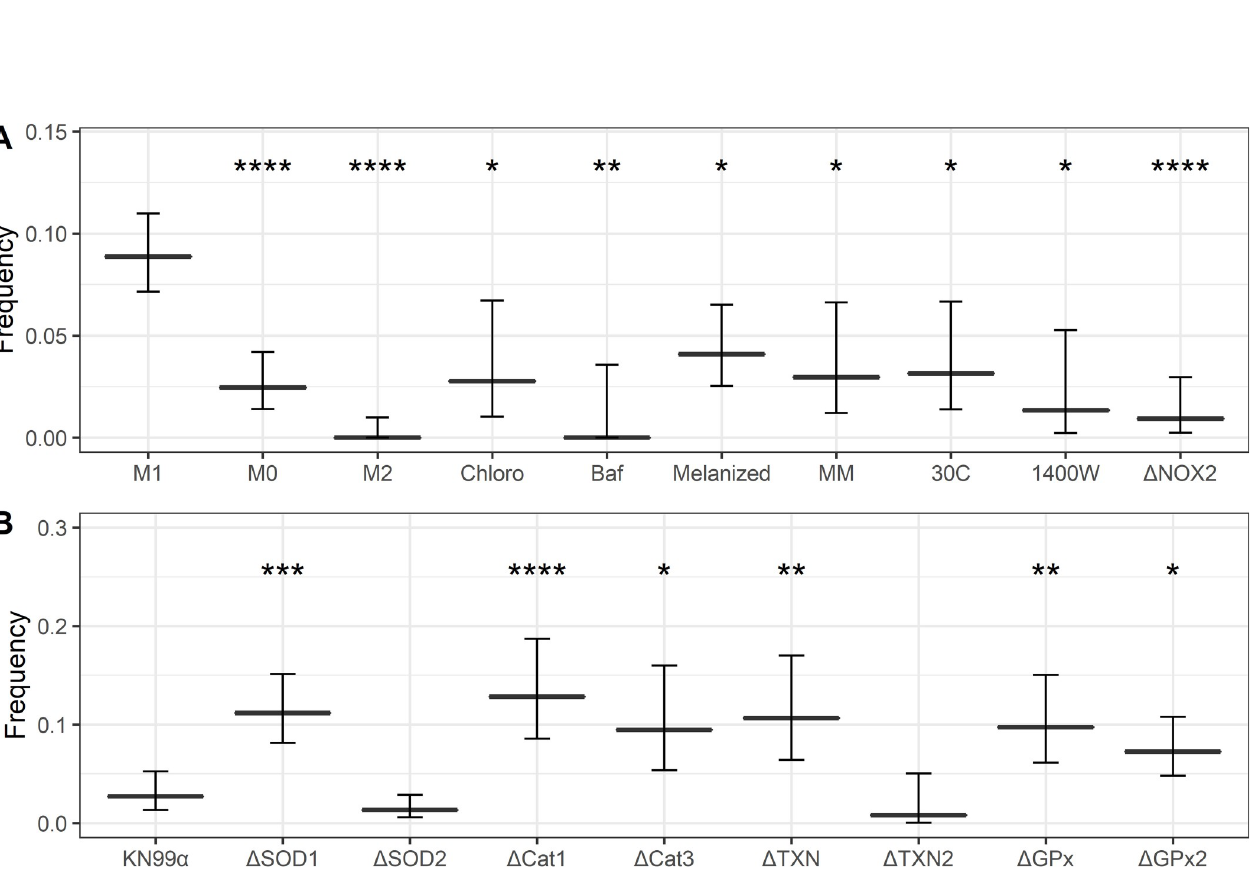
Fig 2. Dragotcytosis frequencies of C . neoformans ingested BMDMs under various conditions. A. C . neoformans strain H99 frequencies of Dragotcytosis. M0 and M2 macrophages have lower frequencies of Dragotcytosis overall compared to M1. Alkalizing the phagolysosomes of M1 macrophages with chloroquine (Chloro) or bafilomycin A1 (BafA), protecting from ROS with melanin (Melanized), stimulating capsule growth with minimal media conditions (MM), and inhibiting macrophage function with low temperature (30C) also abrogate Dragotcytosis frequency. Data was gathered from n of 901, 569, 478, 180, 130, 440, 203, 222, 149, and 619 for M1, M0, M2, Chloroquine (Chloro), Bafilomycin (Baf), Melanized, Capsule Induced (MM), 30C, 1400W, and Δ NOX2 respectively. B. C . neoformans strain KN99 α Dragotcytosis frequencies among infected macrophages. Knocking out genes directly involved in oxidative stress mitigation increases frequency of Dragotcytosis. Data was gathered from n of 333, 340, 522, 187, 137, 150, 125, 195, and 330 for KN99 α , Δ SOD1, Δ SOD2, Δ Cat1, Δ Cat3, Δ TXN, Δ TXN2, Δ GPx, and Δ GPx2 respectively. Graphs depict means with 95% confidence intervals. � , �� , ��� , ���� denote P < 0.05, 0.01, 0.001, and 0.0001 via test of equal proportions compared to M1 with Bonferroni correction for multiple hypotheses. Boxplots signify median with 95% confidence interval tails.